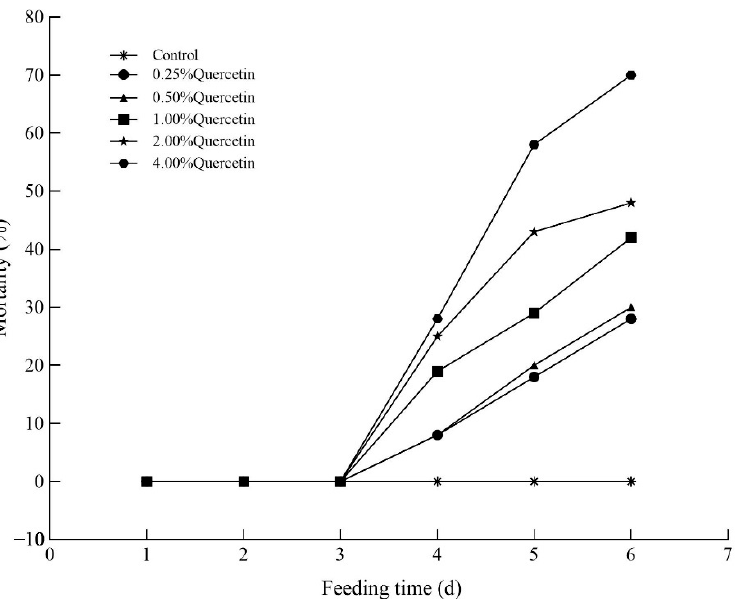
Figure 1. The mortality of fifth-instar Hyphantria cunea fed on diets containing different concentrations of quercetin. Significant differences among treatments were calculated using Tukey’s test at p < 0.05. Control, artificial diet containing 20% DMSO.